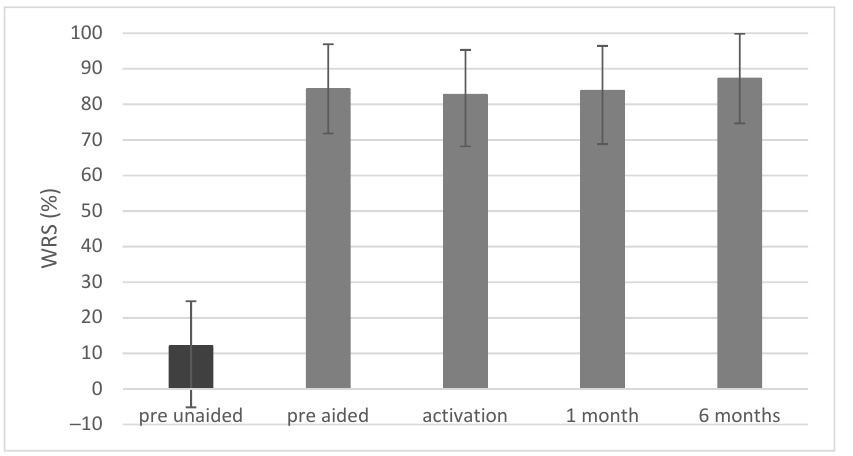
Figure 7. Word recognition scores (WRSs) in quiet obtained in free-field audiometry at 65 dB SPL. All differences between pre-unaided and all other conditions are statistically significant at p < 0.001. The bars represent mean scores, the error bars are standard deviations.